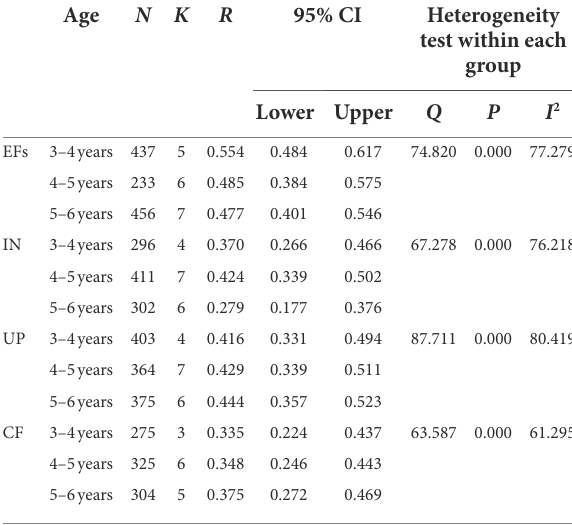
TABLE 4 The moderating effect of age on executive functions and mathematical competence in preschool